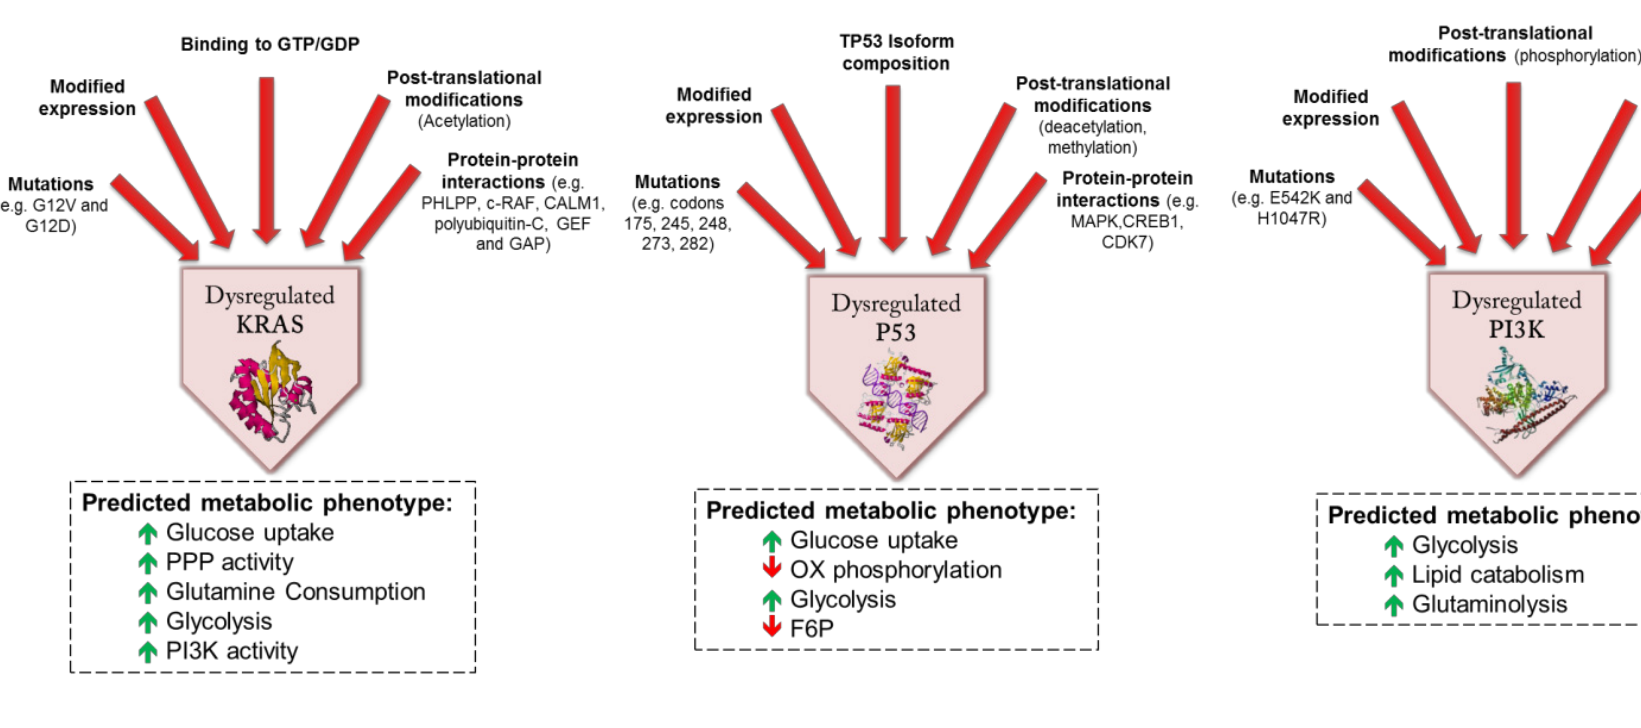
Figure 5. Examples of predicted metabolic effects of dysregulated proteins associated with CRC. The proteins are dysregulated as a consequence of modulatory molecular events at multiple levels. Alterations in metabolic function (and ultimately phenotype) result from the closely connected functional networks’ response to these upstream signals. (GDP: guanine diphosphate; GTP: guanine triphosphate; GEF: guanine nucleotide-exchange factor; GAP: GTPase-activating protein; PPP: pentose phosphate pathway)